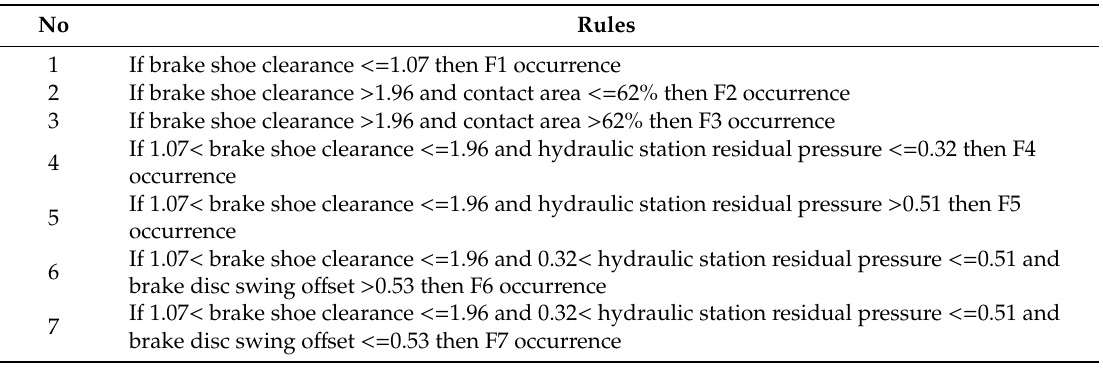
Table 8. The fault data set generates rules under the K_C4.5 algorithm.